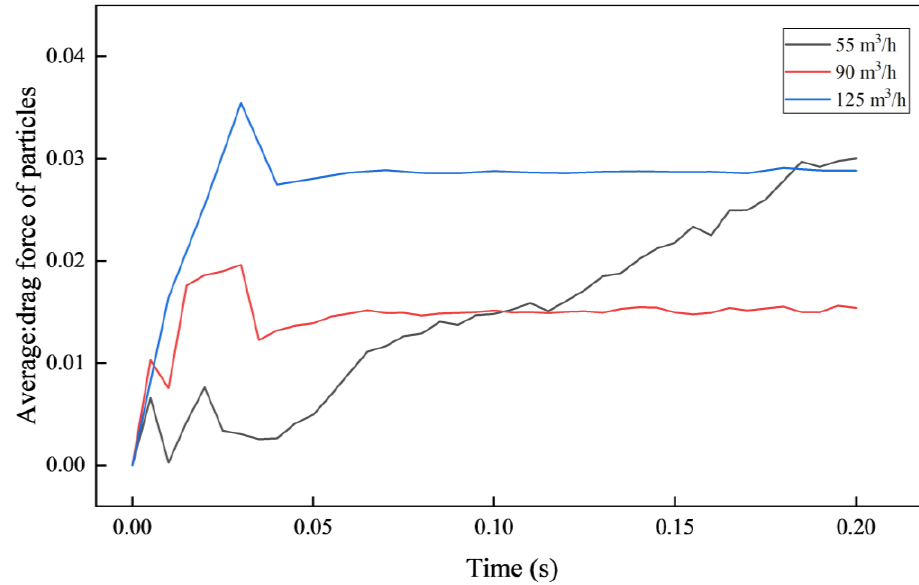
Figure 19. The magnitude of the pulling force of 1.4 mm LCMs at different displacements.